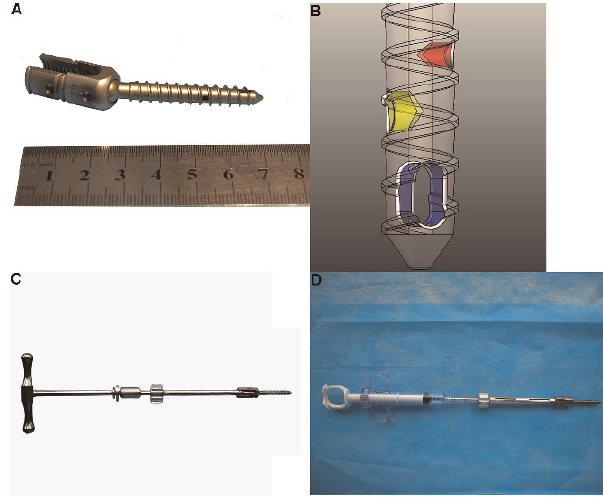
Figure 1 - A: The CICPS. B: Three side holes were arranged from smallest to largest at the distal end of the screw. C and D: The CICPS connects to the T-shaped handle and the specially designed bone cement syringe through an